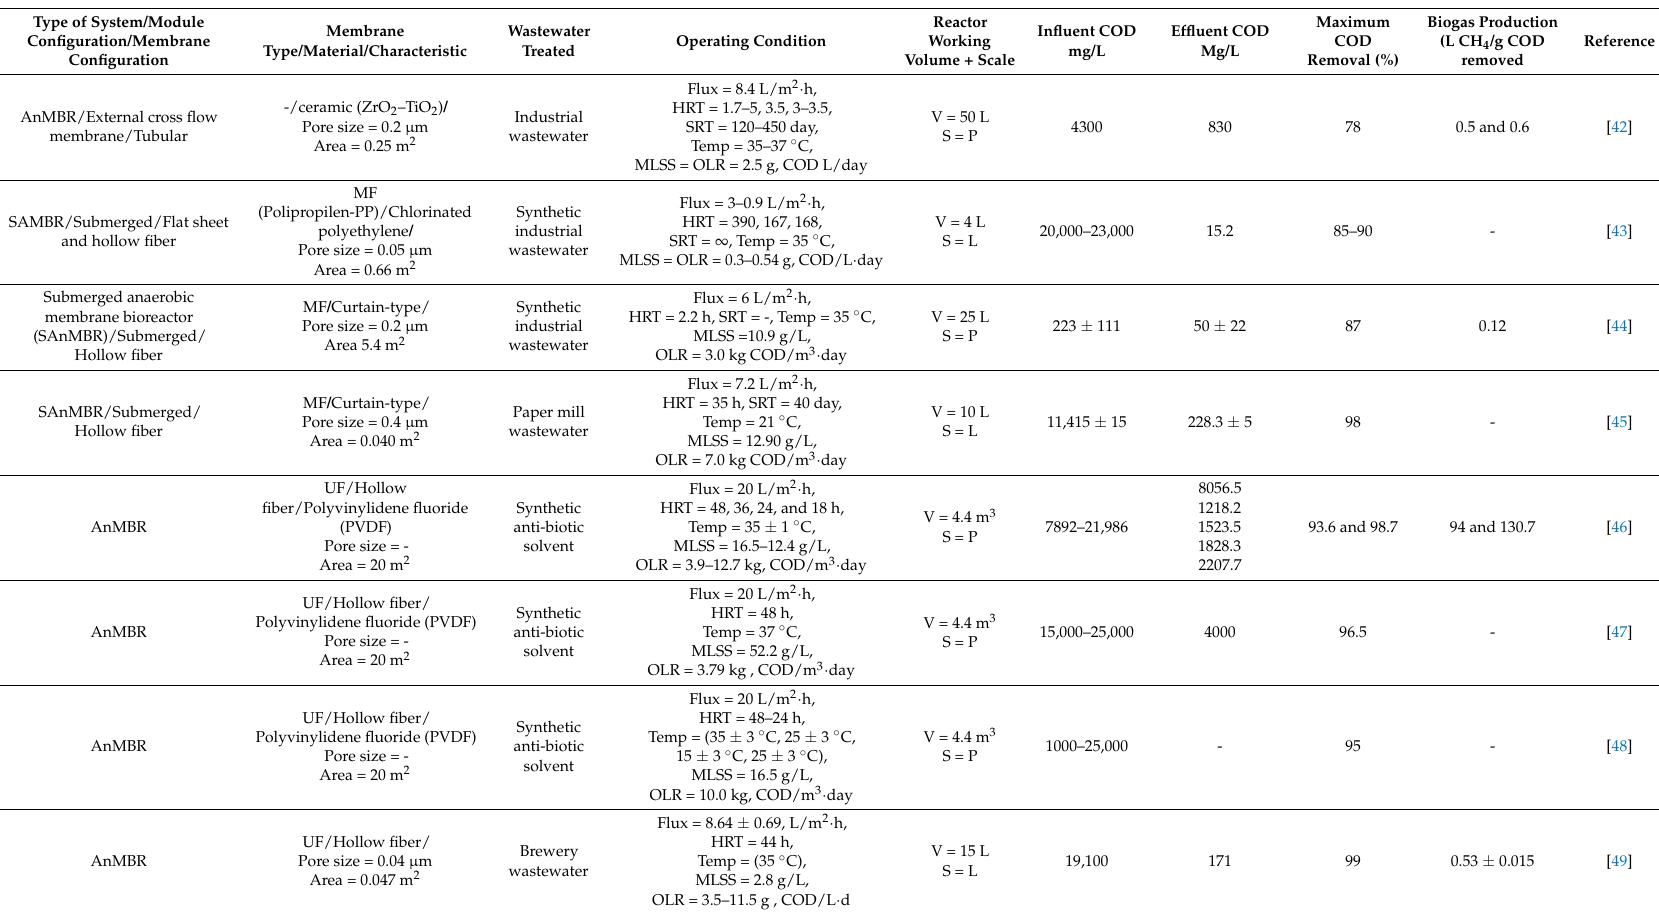
Table 2. References on anaerobic membrane bioreactors (AnMBRs) for industrial